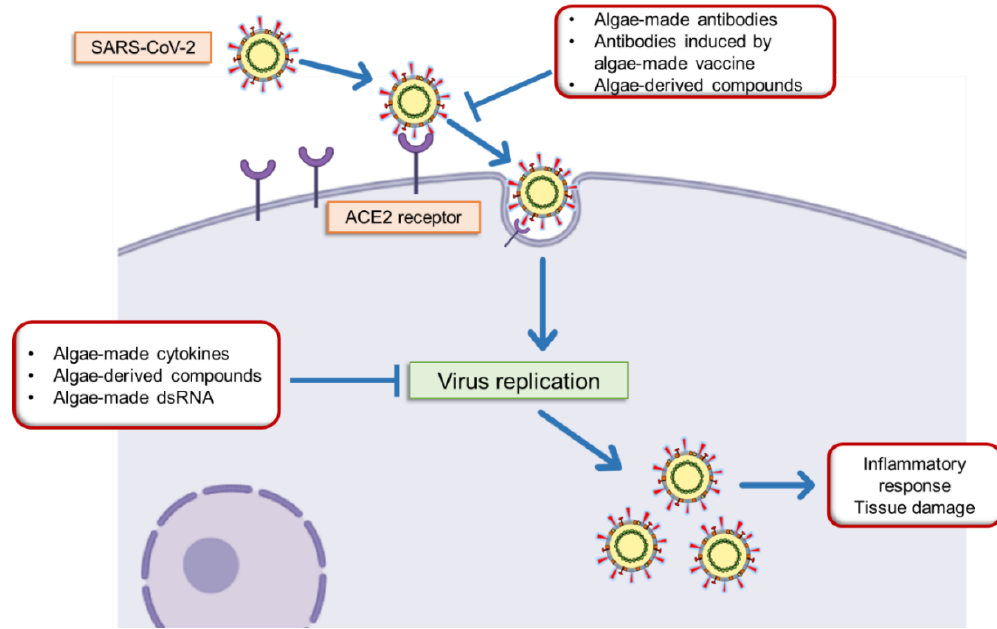
Figure 1. Simplified view of the SARS-CoV-2 pathogenic mechanisms and possible algae-based products to fight against it. The SARS-CoV-2 access the cells at the airway mucosa by targeting the ACE2 receptor. Upon cell entry, viral replication takes place and induces tissue damage that might result in a severe inflammatory response and systemic spread, which can cause death; especially in patients suffering of co-morbidities. Microalgae can be exploited in several directions as sources of drugs and biologicals in the fight against SARS-CoV-2 infection. Algae-derived compounds such as lectins and polysaccharides have known ability to block the entry or replication of enveloped viruses. Through genetic engineering; algae can lead to the development of low-cost production platforms for the manufacture of vaccines, monoclonal antibodies, and cytokines; all of them being key biopharmaceuticals in the prevention or treatment of COVID-19.